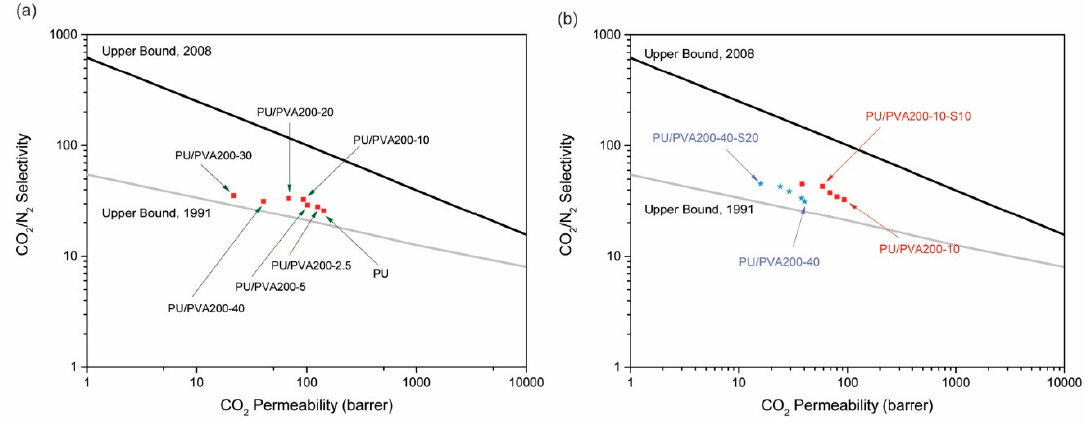
Figure 5. SEM images of ( a ) PU/PVA200–40-S5 and ( b ) PU/PVA200–40-S20.